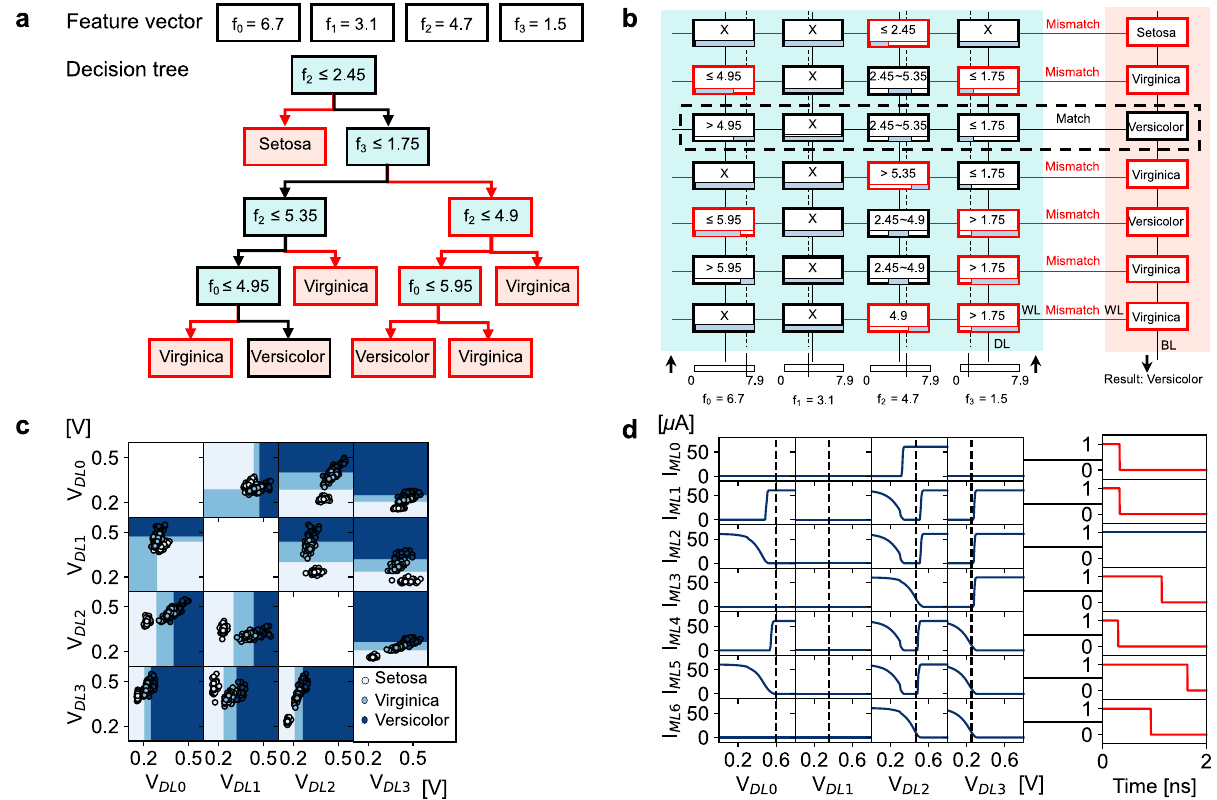
Fig. 3 Mapping decision tree on analog CAM. a Decision tree for classifying the Iris dataset; a feature vector is given as input and features are compared with learned thresholds to decide which branch of the tree to take. b Analog CAM array mapping the decision tree of a , where each root-to-leaf path is written in an array row. Classi fi cation outputs are given on the ML, in one shot. c Decision map of different DT trained with two features of the feature vector, calculated in the analog CAM. d Current fl owing in every analog CAM cell as a function of V DL and resulting ML digital output for the inference of feature vector and DT in a